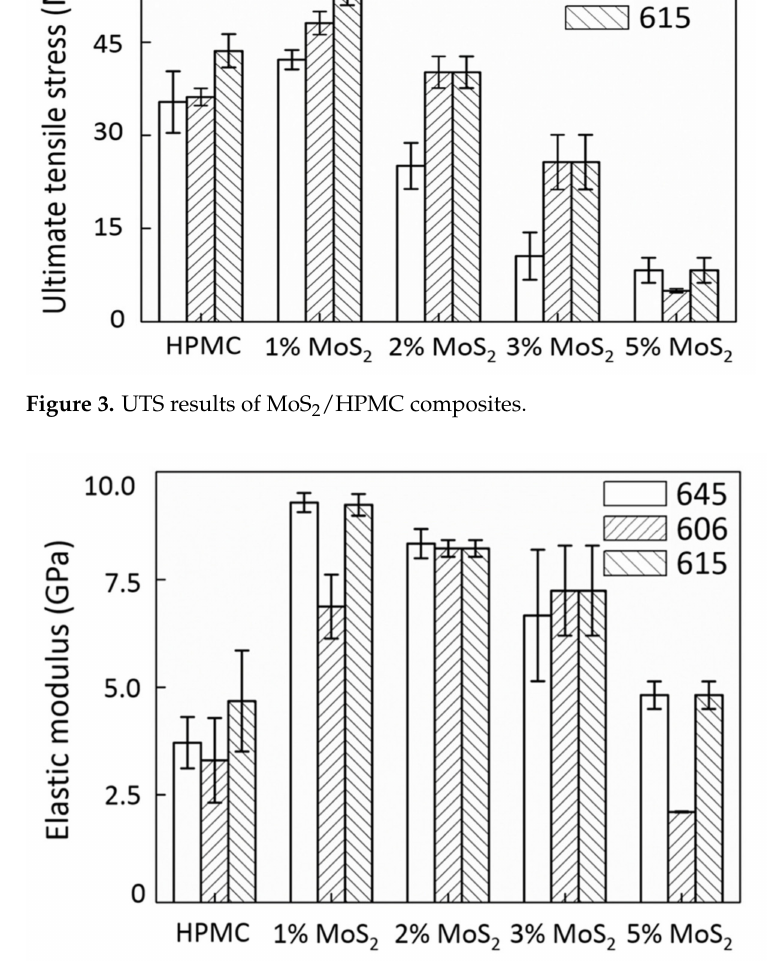
Figure 4. Elastic modulus of MoS 2 /HPMC